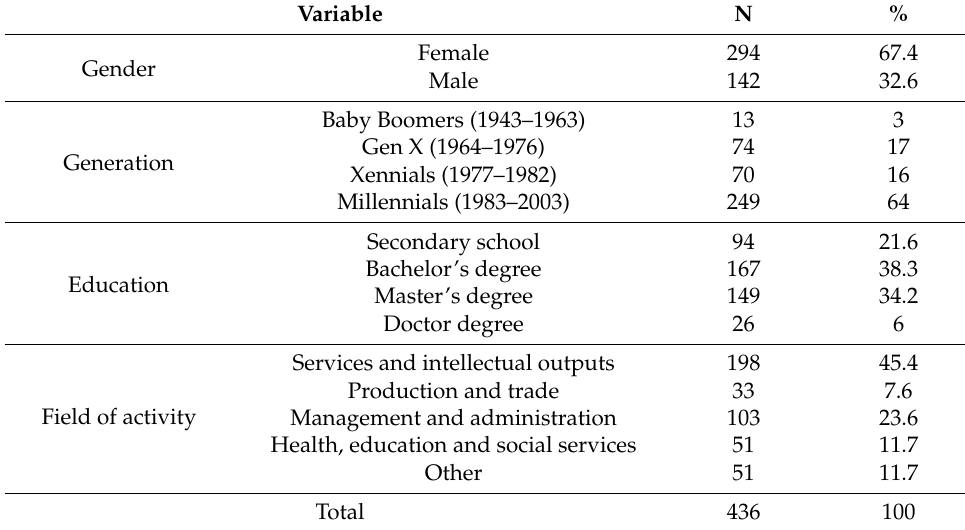
Table 1. Socio-demographic characteristics of the respondents.